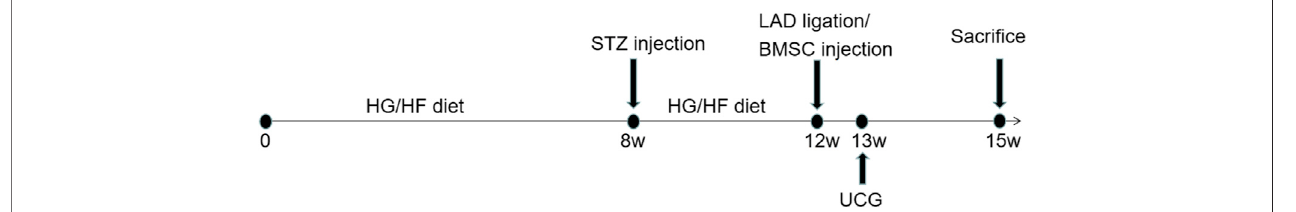
FIGURE 4 | Experimental protocol of the in vivo test. Normal male SD rats were fed with high-sugar and high-fat diet for 8 weeks. 1% STZ was injected with 25 mg/kg establish a type 2 diabetes model. The rats continued to be fed with high-sugar and high-fat diet for 4 weeks. Then the LAD were ligated and BMSCs with different stimulation were transplanated into the border of the infarction area. 1 week after this surgery, echocardiography was taken to measured the cardiac function and 3 weeks after, these rat were sacri fi ced for further